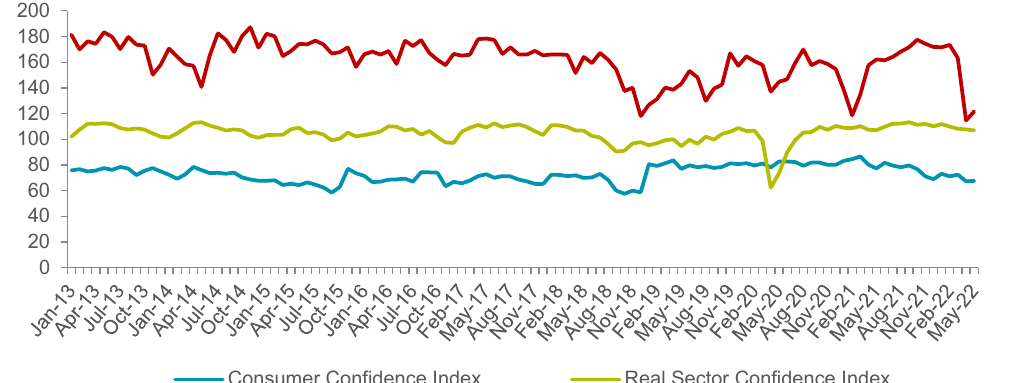
Figure 9 Consumer / Real Sector Confidence Index, TURKSTAT and CBRT, 2022